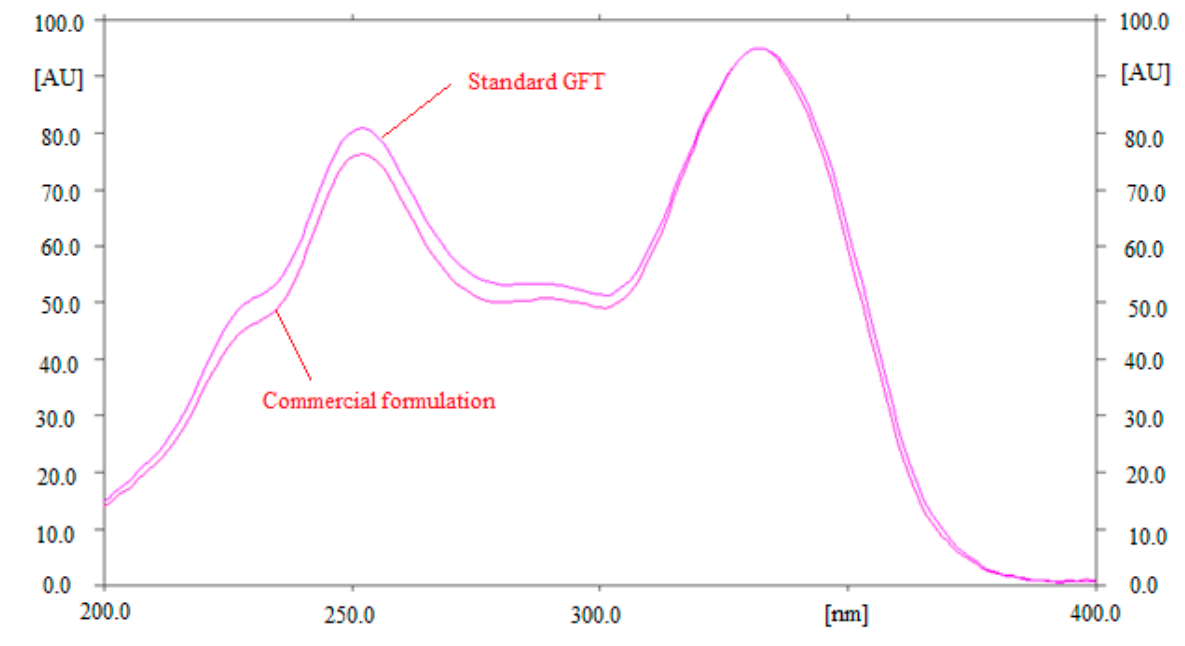
Figure 2. Ultra-violet (UV) absorption spectra of standard GFT and commercial formulation, super- imposed.